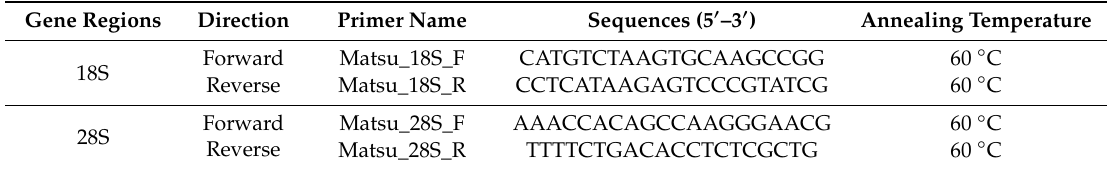
Table 2. Primers used in this